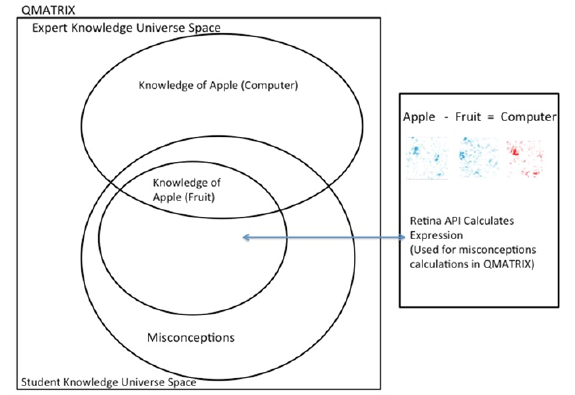
Figure 4. A conceptual dialog mapping of